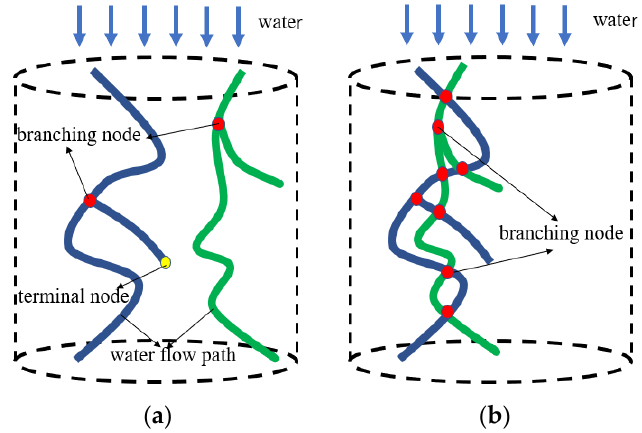
Figure 9. Graphs representing the through-depth water flow path pattern of porous asphalt concrete: ( a ) non-cross-linked; ( b ) cross-linked.